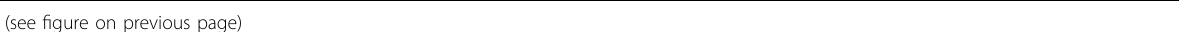
Fig. 6 Overexpression of circ_0000296 against CCI induced neuronal apoptosis in vivo. a Terminal deoxynucleotidyl transferase (TdT)- mediated dUTP-biotin nick end labelling (TUNEL) assay (×200, scale bar = 50 μ m) sections of the hippocampus CA1 region of Sham ( n = 15) and CCI ( n = 20) group. Data represented as mean ± SD.* P < 0.05 vs. Sham group. b Flow cytometry analysis of CCI-induced HT22 cells with annexin V/PI staining. Data represented as mean ± SD. ( n = 3, each group). * P < 0.05 vs. HT22 in normal group. c TUNEL assay (×200, scale bar = 50 μ m) sections of the hippocampus CA1 region of CCI ( n = 20), CCI + circ_0000296( + )-NC ( n = 20) and CCI + circ_0000296( + ) group ( n = 15). Data represented as mean ± SD. * P < 0.05 vs. CCI + circ_0000296( + )-NC group. d Experimental schedule to explore the effects of circ_0000296 on CCI-induced neuronal damage in vivo. e The schematic cartoon of the mechanism of circ_0000296/miR-194-5p/Runx3/Sirt1 axis regulating neuronal